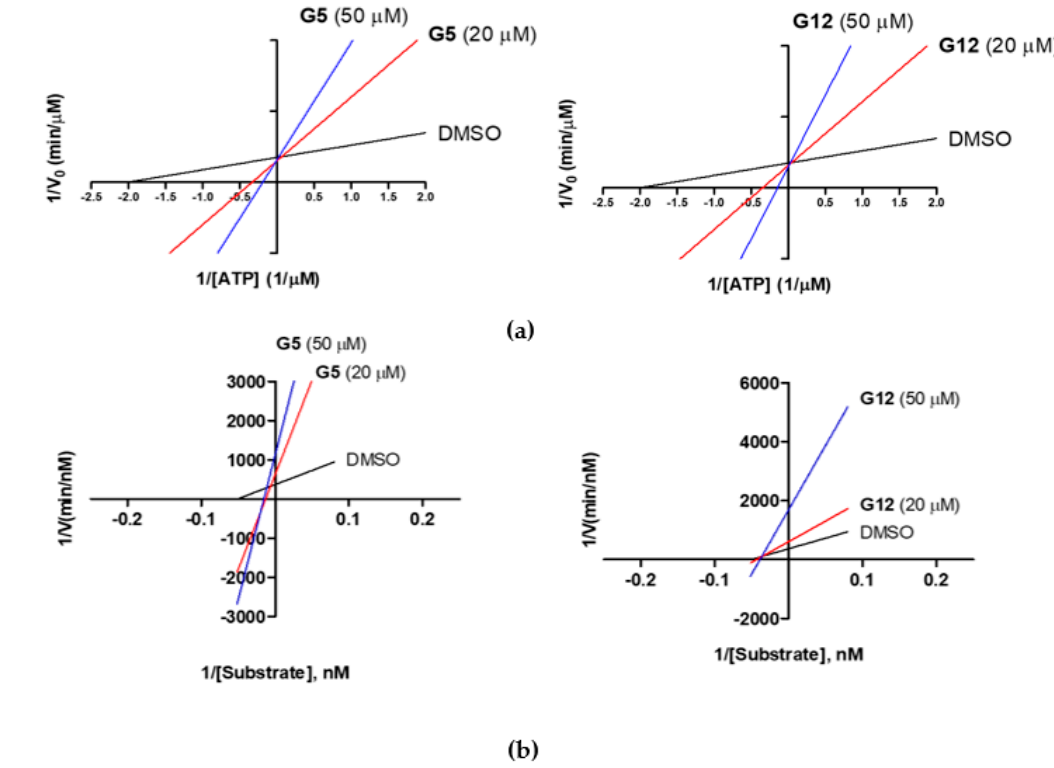
Figure 6. Lineweaver − Burk plots of GSK-3 β kinetic data at two concentrations of G5 and G12 (20 and 50 µM). ( a ) Linear regression plotting of 1/V against 1/[ATP] at a given concentration of the compound. Intersecting at the same point on the y-axis indicates competitive inhibition with respect to ATP; ( b ) Linear regression plotting of 1/V against 1/[Substrate] at a given concentration of the compound. Intersecting at the same point on the x-axis indicates noncompetitive inhibition (G12), while for G5 the x intercept shifts right, suggesting a mixed inhibition with respect to the substrate.